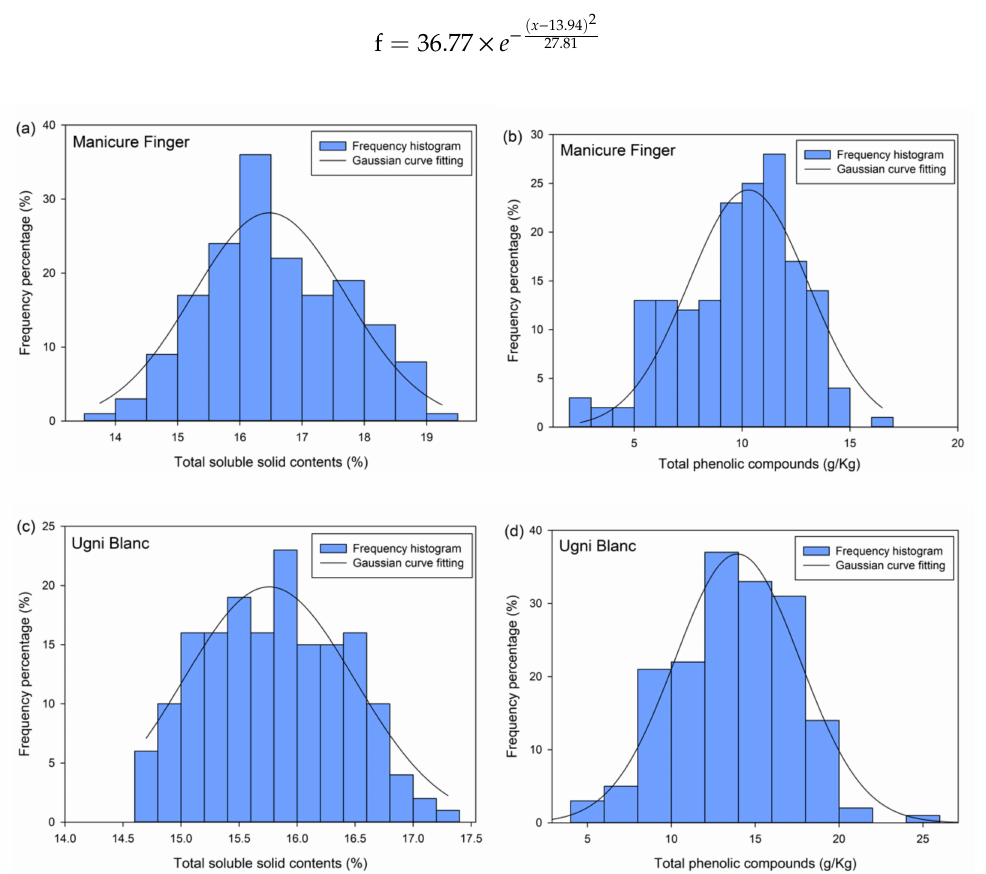
Figure 2. Frequency histograms and Gaussian curve fitting for total soluble solid content and total phenolic compounds. (( a ), frequency percentage of SSC in Manicure Finger; ( b ), frequency percentage of TP in Manicure Finger; ( c ), frequency percentage of SSC in Ugni Blanc; ( d ), frequency percentage of TP in Ugni